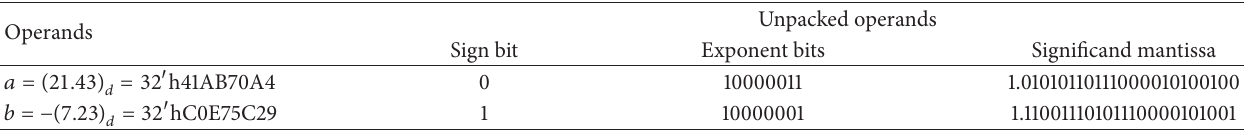
Table 3: Representation of input operands in the form of IEEE 754 standard.